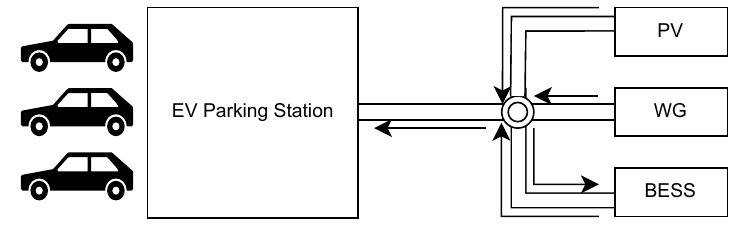
Figure 1. Microgrid